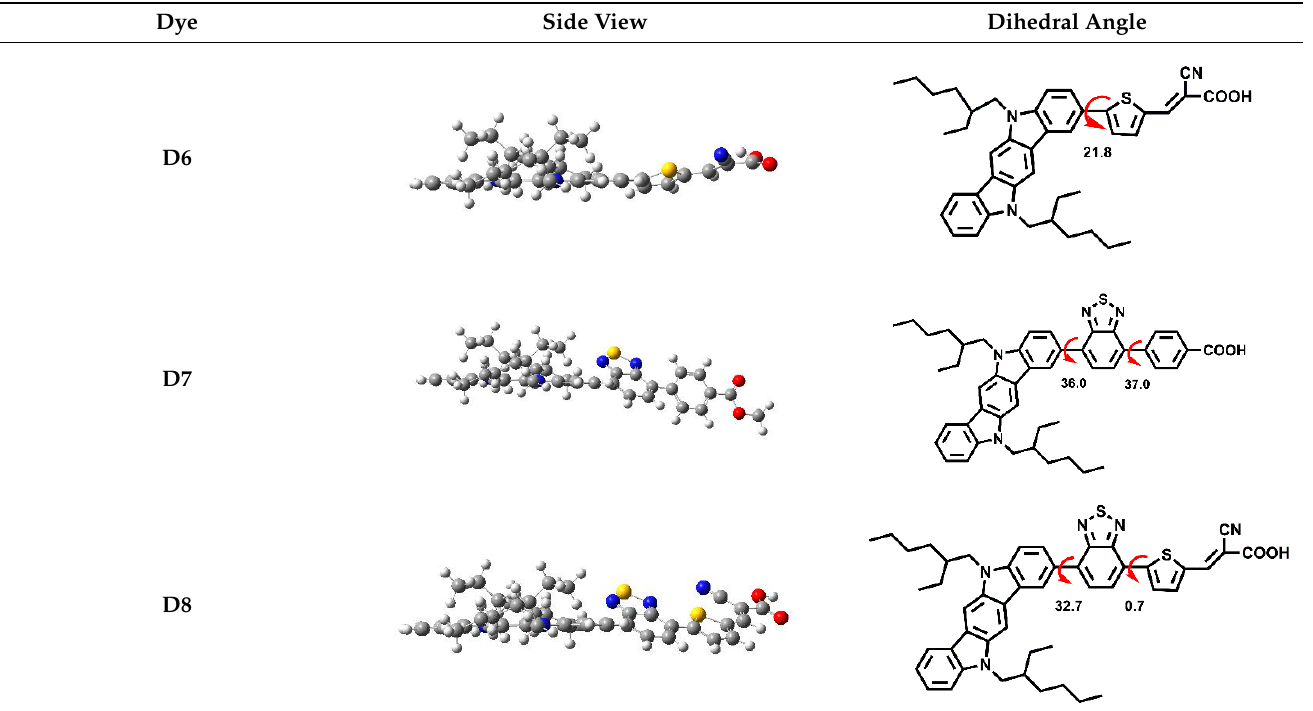
Table 3. Dihedral angle and side views of the dyes.